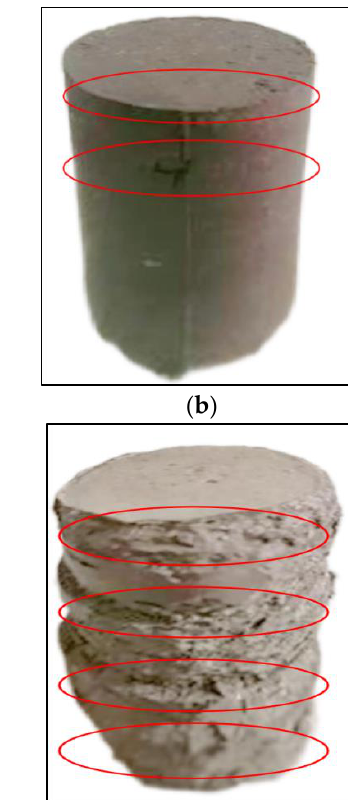
Figure 25. Morphology of solidified waste silt before and after drying and wetting cycles when w g = 6%: ( a ) N dw = 0, ( b ) N dw = 1, ( c ) N dw = 3, ( d ) N dw = 6.